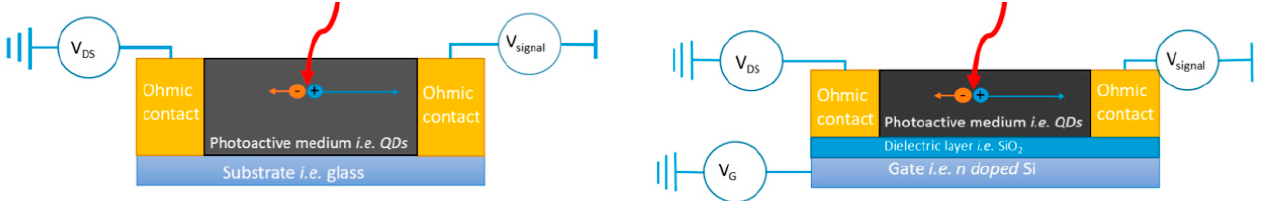
Figure 4. Photoconductor scheme ( left ) and phototransistor scheme ( right ). Adapted with permission from ref. [49].